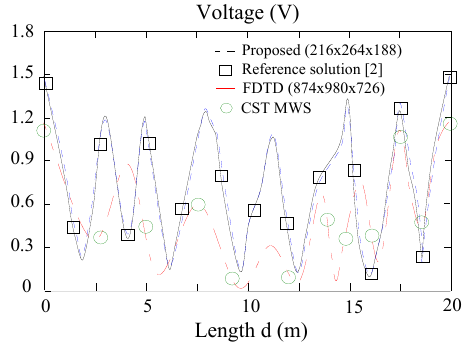
Figure 23: (a) Amplitude of the normalized E versus frequency in the interior of the chamber and (b) shield- ing effectiveness for a 1.5 mm thick fiber-glass-fiber plate.